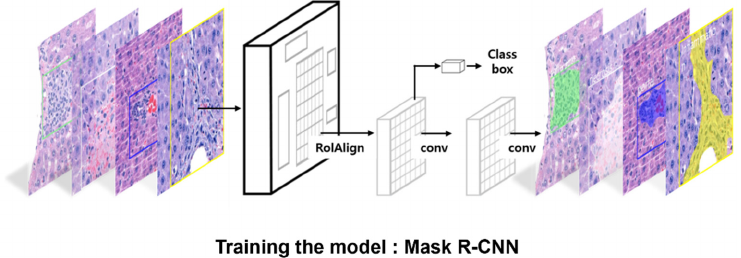
Figure 1. Schematic of the procedures for Mask R-CNN and segmentation of hepatic lesions.